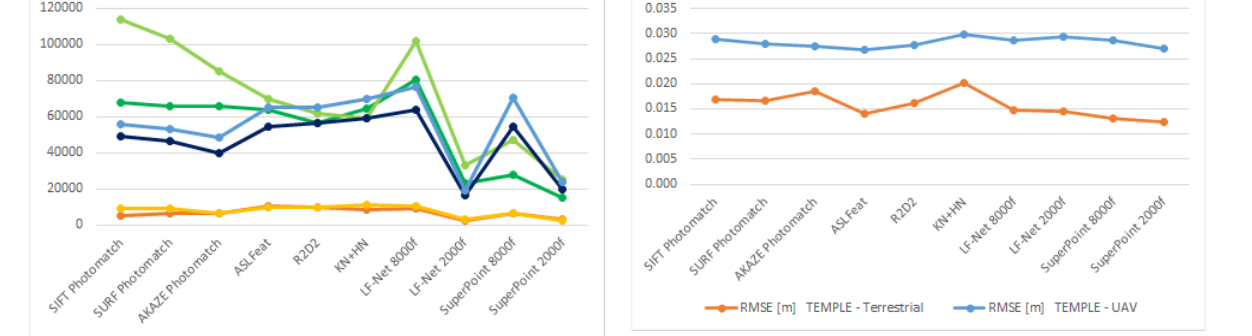
Figure 5: Computed 3D points (sparse cloud) within the bundle adjustment. In Paestum Wall Perpendicular + Oblique , ASLFeat, R2D2 and Key.Net+HardNet methods, having a higher MTL, create significantly fewer 3D points.